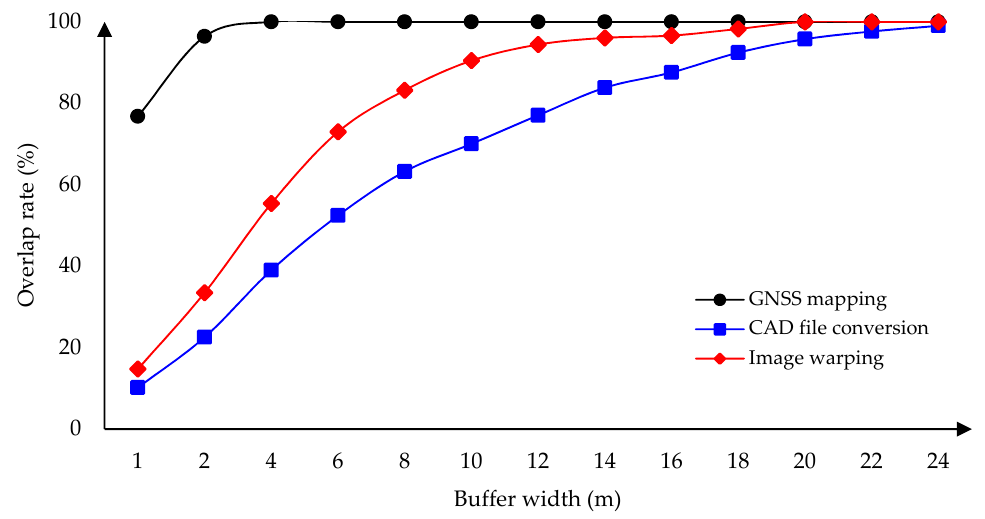
Figure 6. Results of bu ff ering analysis by mapping technique. The overlapping rates were average values.